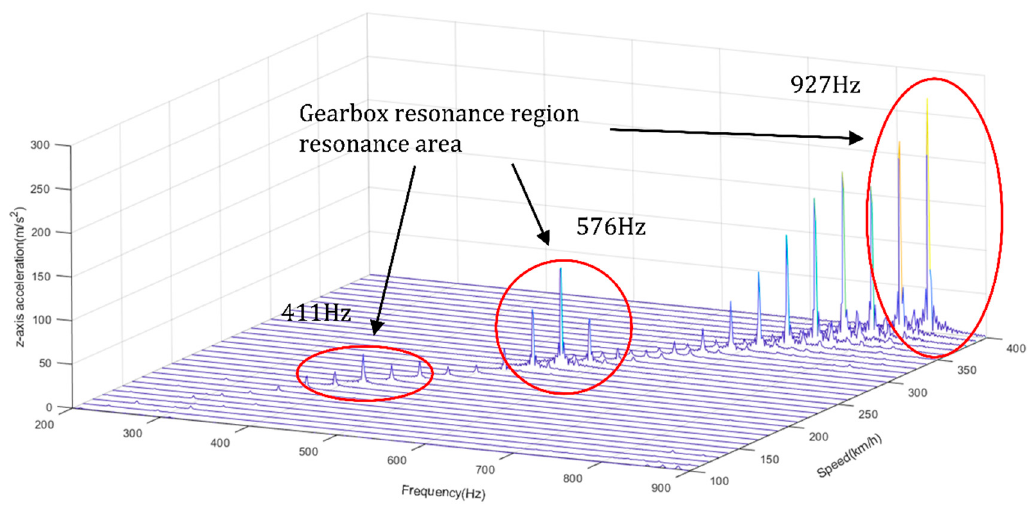
Figure 12. The vertical vibration acceleration of gearbox housing under 20th wheel wear.